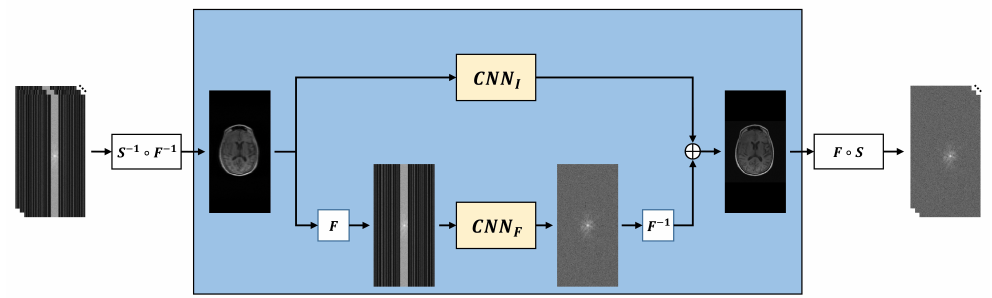
Figure 2. CNN-based regularization block. An MR image is reconstructed in parallel in the image domain and the k-space domain with two U-Nets and then